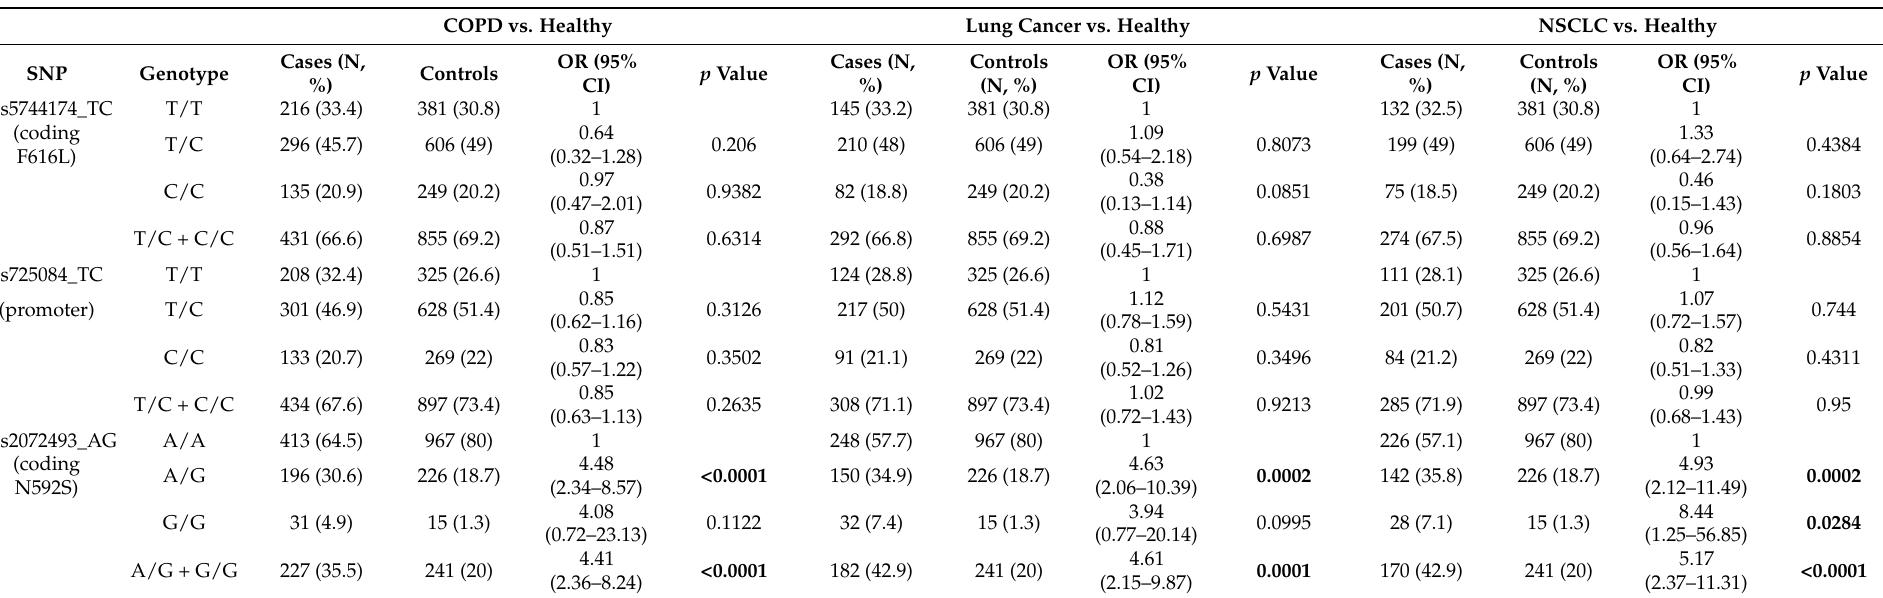
Table 4. Association between selected TLR5 SNPs and risk for chronic obstructive pulmonary disease (COPD) and lung cancer (LC) development. COPD cases were selected independently on lung cancer status and same was performed for lung cancer cases—they were selected independently for COPD status. COPD vs. Healthy Lung Cancer vs. Healthy NSCLC vs.